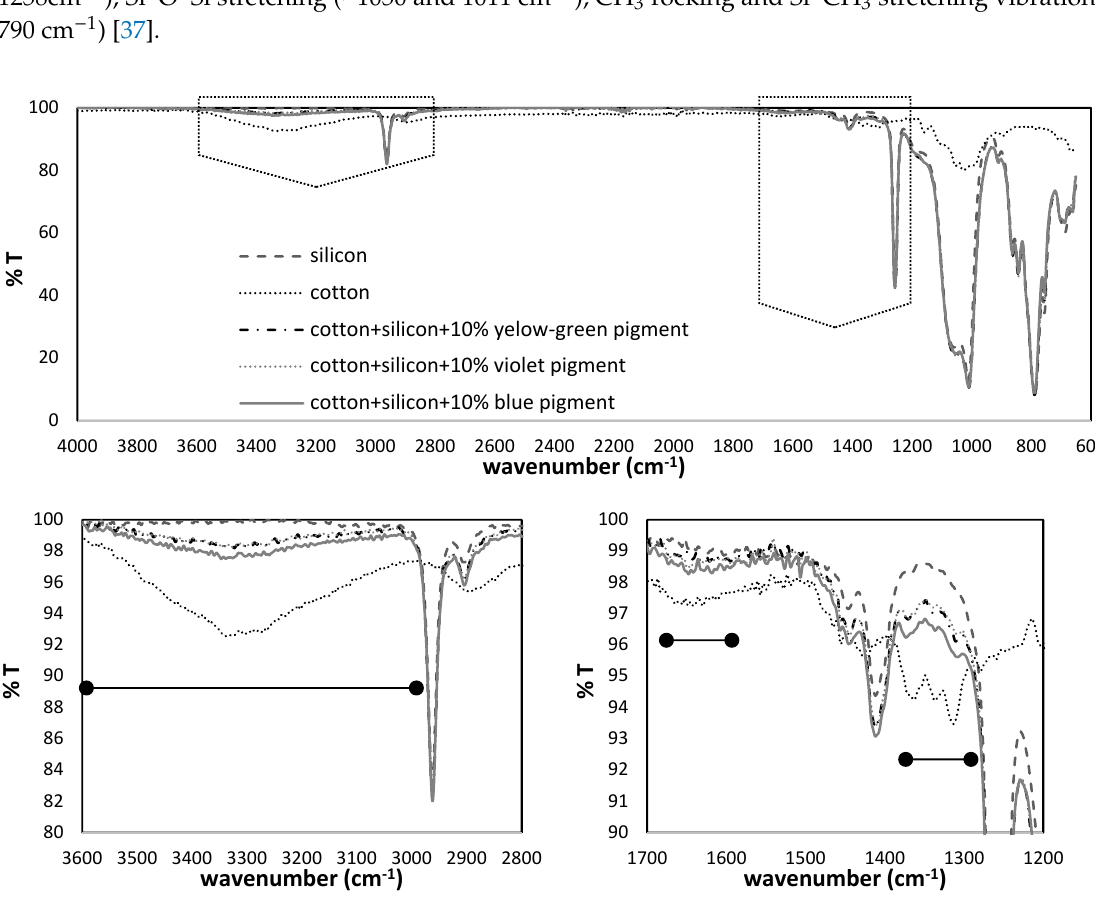
Figure 5. FTIR spectra of cotton fabric, before and after screen-printing, together with the PDMS binder, containing 10 wt % of blue, violet and yellow-green luminescent pigments. The PDMS binder is presented as the control. Regions of interest are presented with a higher resolution.